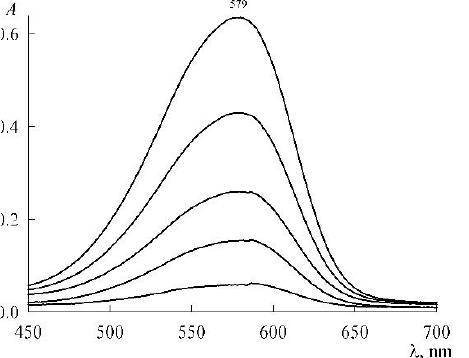
Figure 5. Electronic absorption spectra of NR solutions in the presence of 30 mM SDS with NR concentrations (from bottom to top, M) 1.38, 4.2, 7.1, 12, and 18.